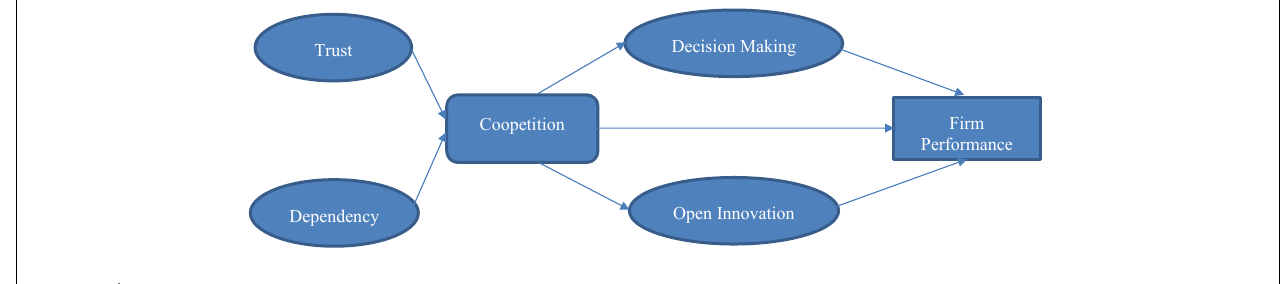
FIGURE 1 | Conceptual